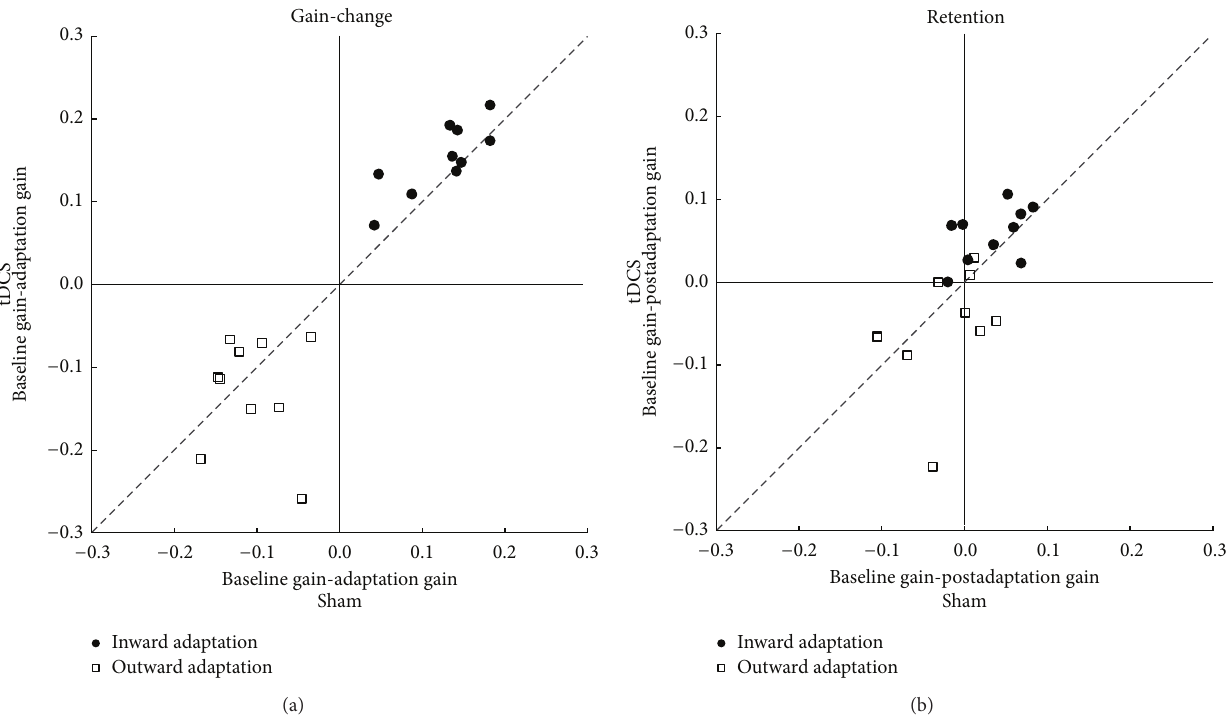
Figure 2: Adaptation gain-change and retention contrast between tDCS and sham condition. (a) Gain-change for inward and outward adaptation in which we can observe higher changes in gain (learning) for inward saccade adaptation with anodal cerebellar tDCS compared to sham stimulation. No difference is observed in outward saccade adaptation gain-change between anodal cerebellar tDCS and sham stimulation. (b) Retention (difference between baseline and postadaptation) for inward and outward adaptation in the two stimulation